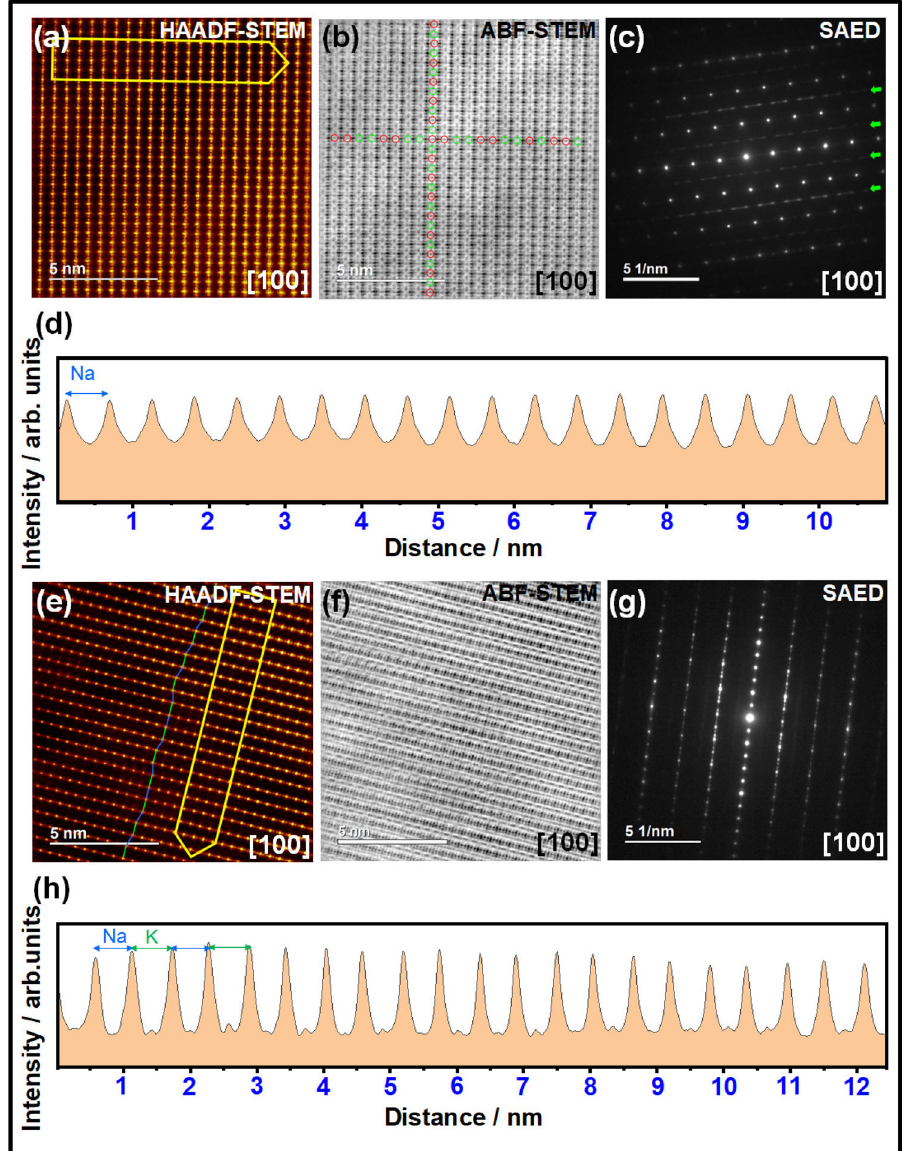
Fig. 5 Structural changes during alkali-ion (de)insertion in NaKNi 2 TeO 6 . a HAADF-STEM ex situ images of NaKNi 2 TeO 6 taken along the [100] axis upon cycling in a Na half-cell (i.e., fully discharged at the third cycle). b Corresponding ABF-STEM images and ( c ) SAED patterns showing streaks (shown in green arrows) indicative of the modulation in the Na arrangement along the ab plane as is exempli fi ed in Na 2 Ni 2 TeO 6 . d Intensity line pro fi les as highlighted in ( a ) showing equidistant interlayer spacings (0.55nm) of Na atoms along the [001] axis. e HAADF-STEM ex situ images of NaKNi 2 TeO 6 taken along the [100] axis upon cycling in a K half-cell (i.e., fully discharged at the third cycle). f Corresponding ABF-STEM images and ( g ) SAED patterns showing streaks indicative of the aperiodic stacking nature along the c -axis. h Intensity line pro fi les as highlighted in ( e ) showing alternating interlayer spacings (0.55nm and 0.62nm) of Na and K atoms, respectively, along the [001] axis. For clarity, the horizontal axes in ( d ) and ( h ) show the number of layers. Intensity line pro fi les that quantitatively illustrate the interlayer spacing values shown in ( d ) and ( h ) are provided as Supplementary Information (Supplementary Figs. 24,